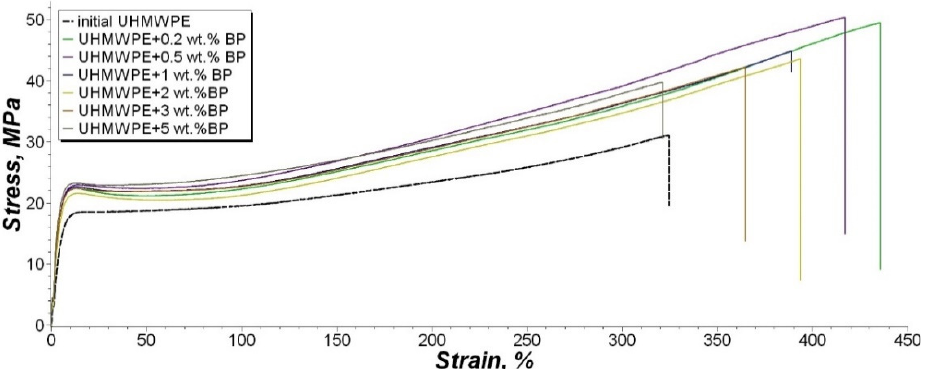
Figure 10. Stress–strain curve of the tensile tests.